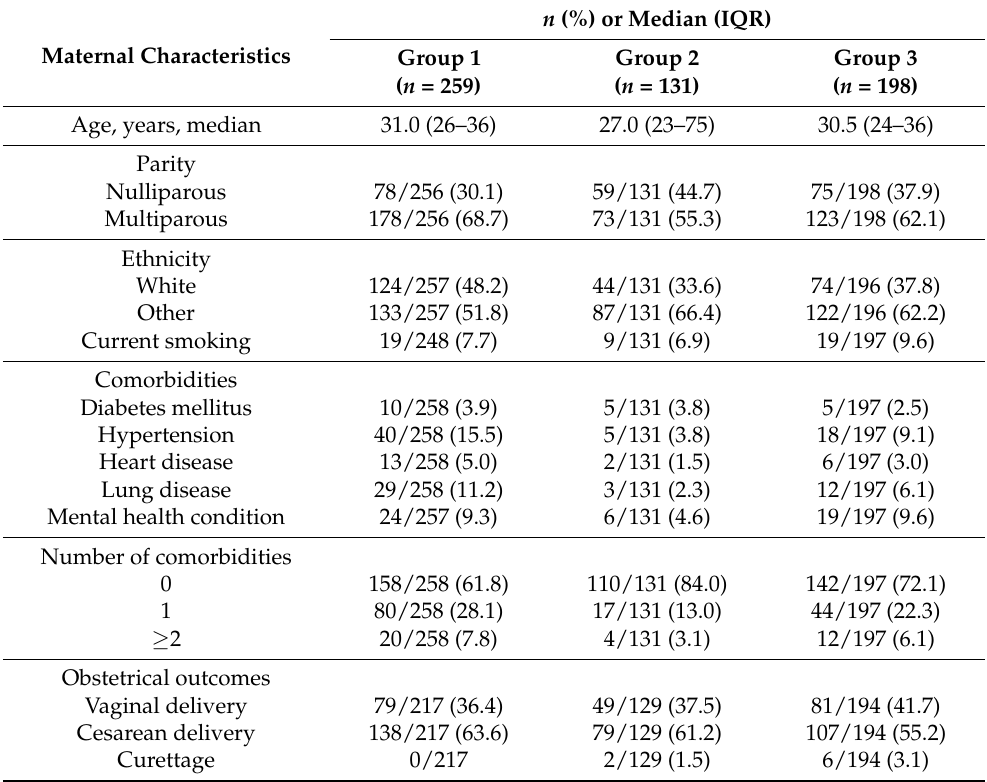
Table 1. Population characteristics ( n = 588).